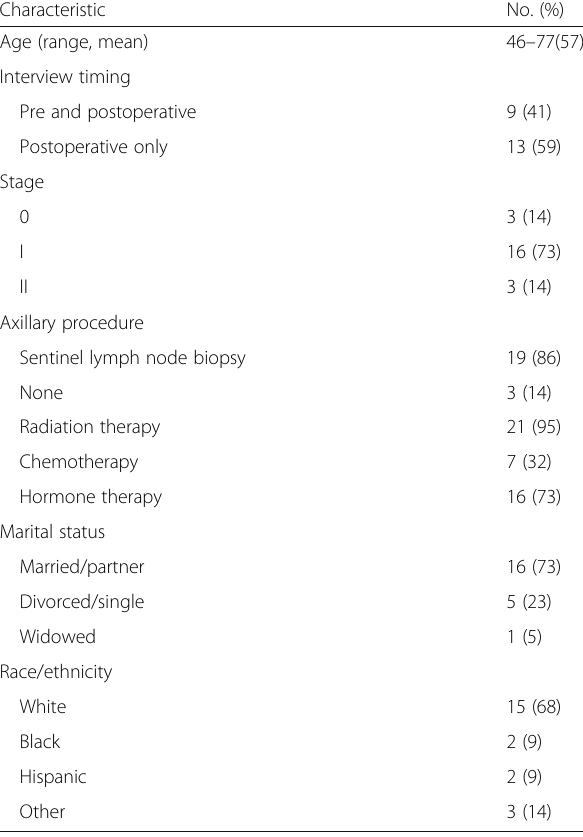
Table 1 Participant demographic and clinical